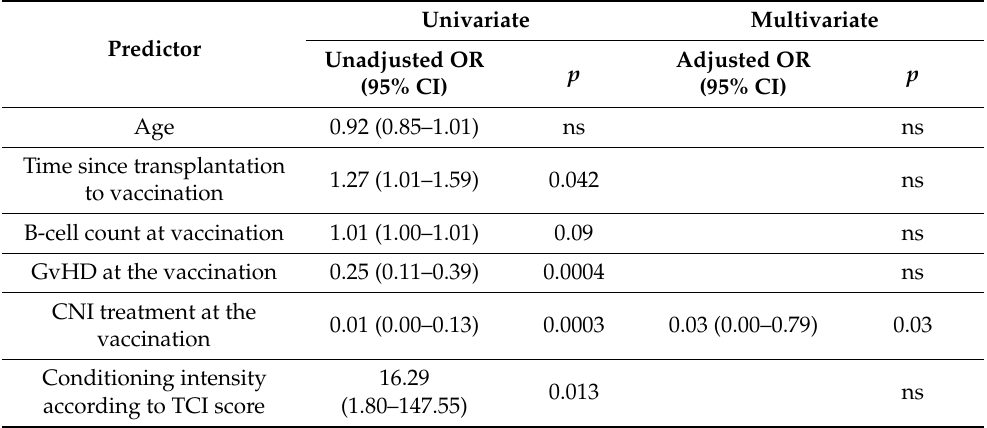
Table 6. Univariate and multivariate logistic regression analysis of factors associated with seroconver- sion after SARS-CoV-2 vaccination in patients after allogeneic hematopoietic stem cell transplantation. Univariate Multivariate Predictor Adjusted OR Unadjusted OR p (95% CI) (95% CI)